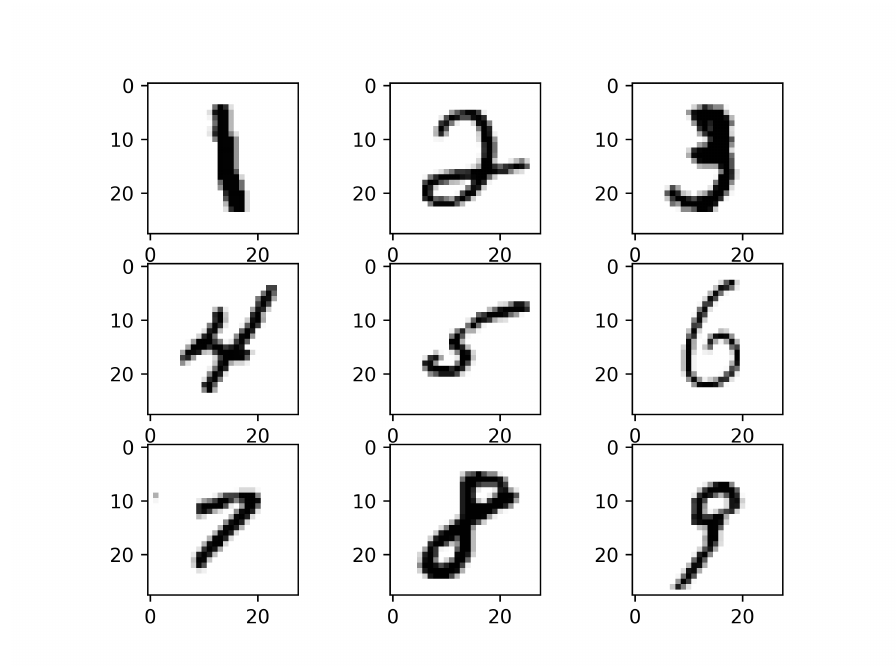
Figure 1. Some samples from the MNIST hand-written digit dataset. (Source: